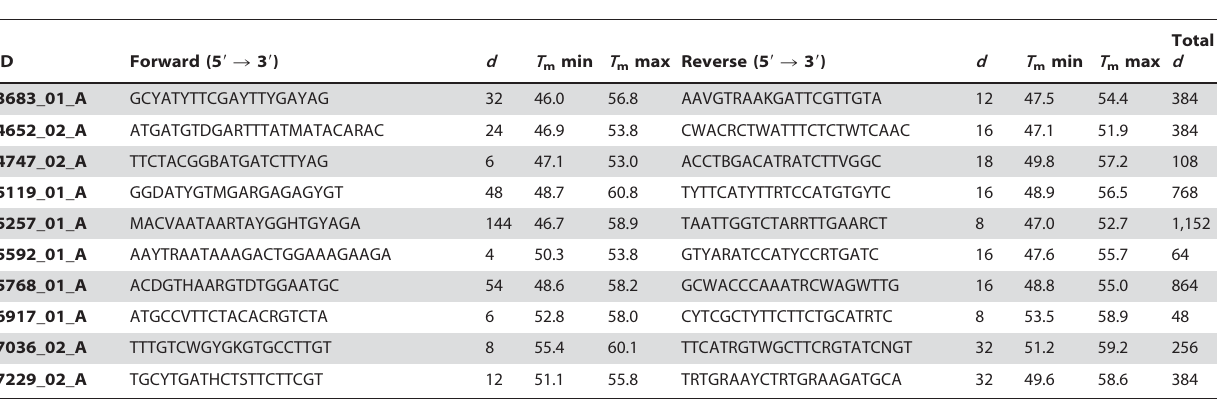
The ten degenerate oligonucleotide primers were tested with the respective binding sites for sequencing primer HOG-Seq-A (see Table 2) attached to the 5 9 end and used to amplify ten target genes in six apocritan Hymenoptera. d = degree of degeneration. T m = approximate melting temperature [ u C].